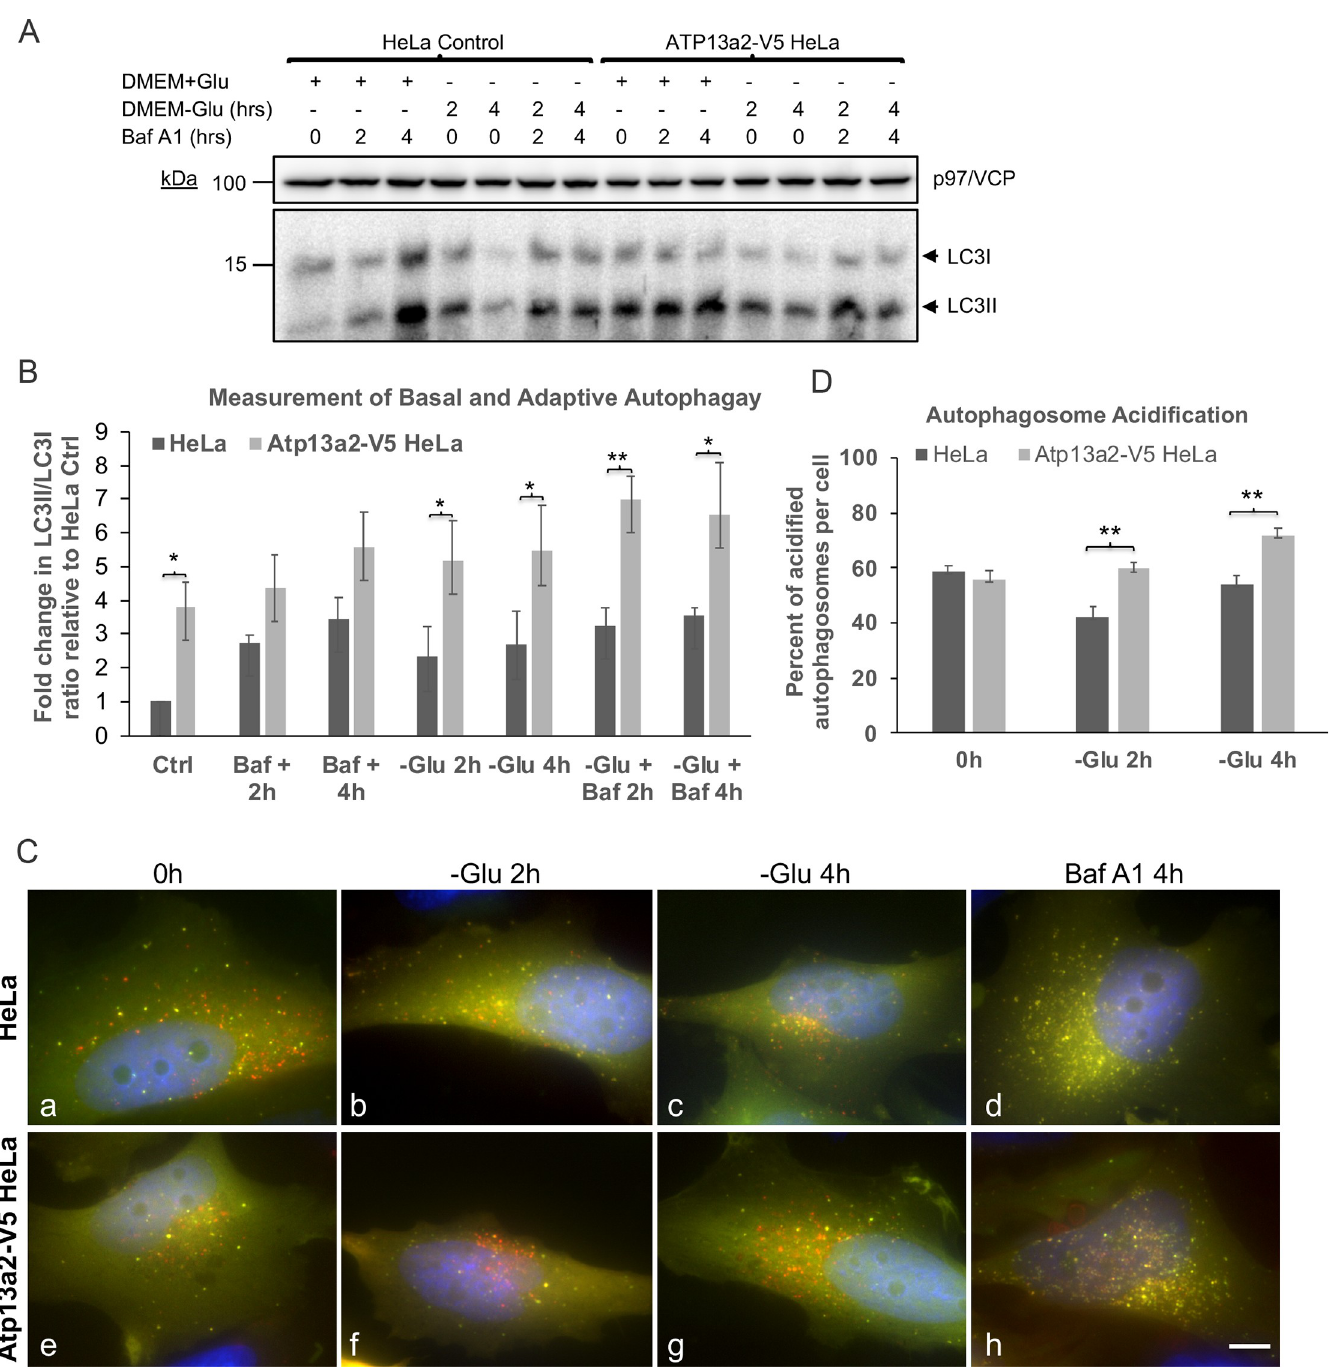
Fig 4. Increase in adaptive autophagy and autophagosome acidification in cells overexpressing Atp13a2. (A) Cells from the normal HeLa line or the line stably expressing Atp13a2-V5 were plated at equal density and the cultures were grown in normal glucose containing medium (+Glu) or shifted to media lacking glucose (-Glu) for the indicated times. Bafilomycin A1 was added to some of the cultures as indicated to block autophagy. Equal amounts of protein from the cultures were immunoblotted for LC3 and p97/VCP, which was used as a loading control. The position of the immature LC3I and lipidated mature LC3II protein are indicated by arrows. (B) Quantification of the ratio of LC3II to LC3I in three independent experiments (see S1 Table). (C) HeLa cells or HeLa cells stably expressing V5-tagged Atp13a2 were grown on coverslips in glucose-containing DMEM medium and transfected with the pDest-GFP-mCherry-LC3B reporter plasmid. The next day the cells were shifted to glucose-free DMEM medium and cultured with, or without Bafilomycin A1, for either 0, 2 or 4 h. The cells were then fixed and stained with DAPI. The individual GFP, mCherry and DAPI fluorescent images of the same cell is provided in S1 Fig, and the result of merging of the three individual images shown for the HeLa (a-d) and Atp13a2-V5 (e-h) cell lines. Bar, 10 μ m. (D) Quantification of the percent of acidified autophagosomes per cell using the GFP-mCherry-LC3B reporter construct. (B, D) � indicate statistical differences determined by Two-way ANOVA analysis ( � p < 0.05, �� p < 0.01). https://doi.org/10.1371/journal.pone.0220849.g004 PLOS ONE | https://doi.org/10.1371/journal.pone.0220849 August 8,